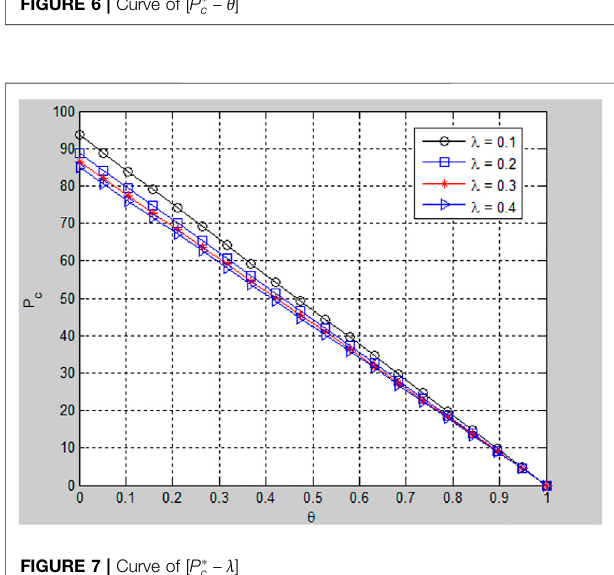
FIGURE 7 | Curve of [ P p c − λ ]